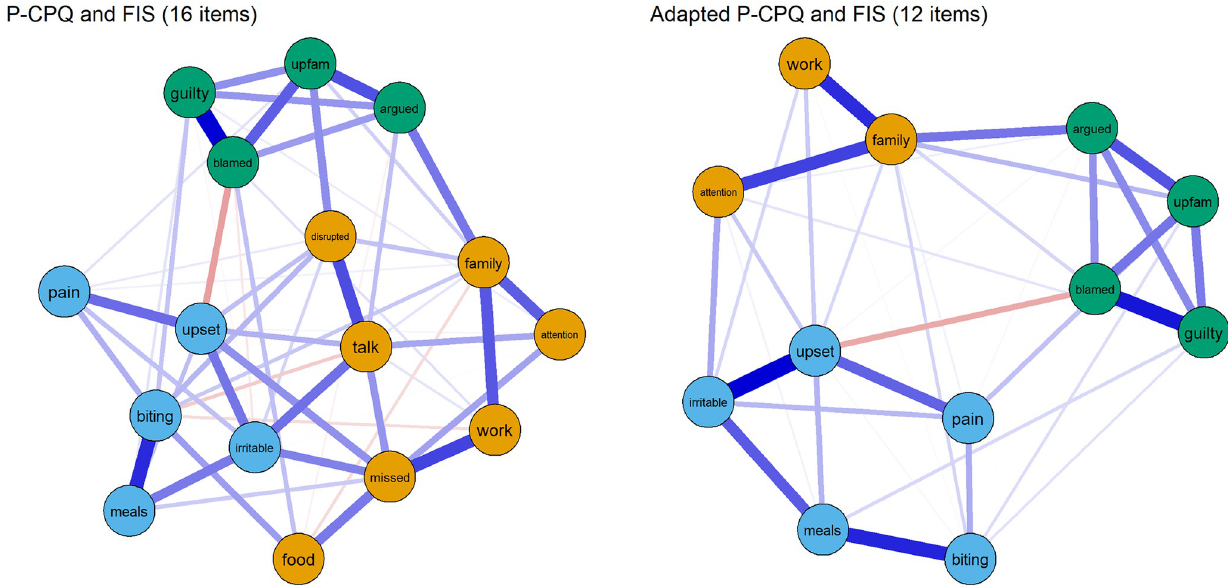
Fig 2. Network of the P-CPQ and FIS items. Note. Positive edges are displayed as blue lines and negative edges are displayed as red lines. Edge weights are represented by the thickness and saturation of the edges. The nodes are coloured according to their EGA-identified dimension.